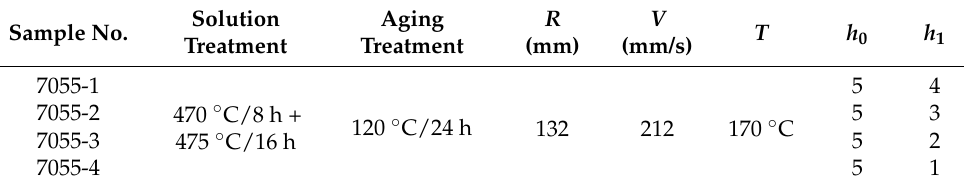
Table 2. Specific process parameters of samples.